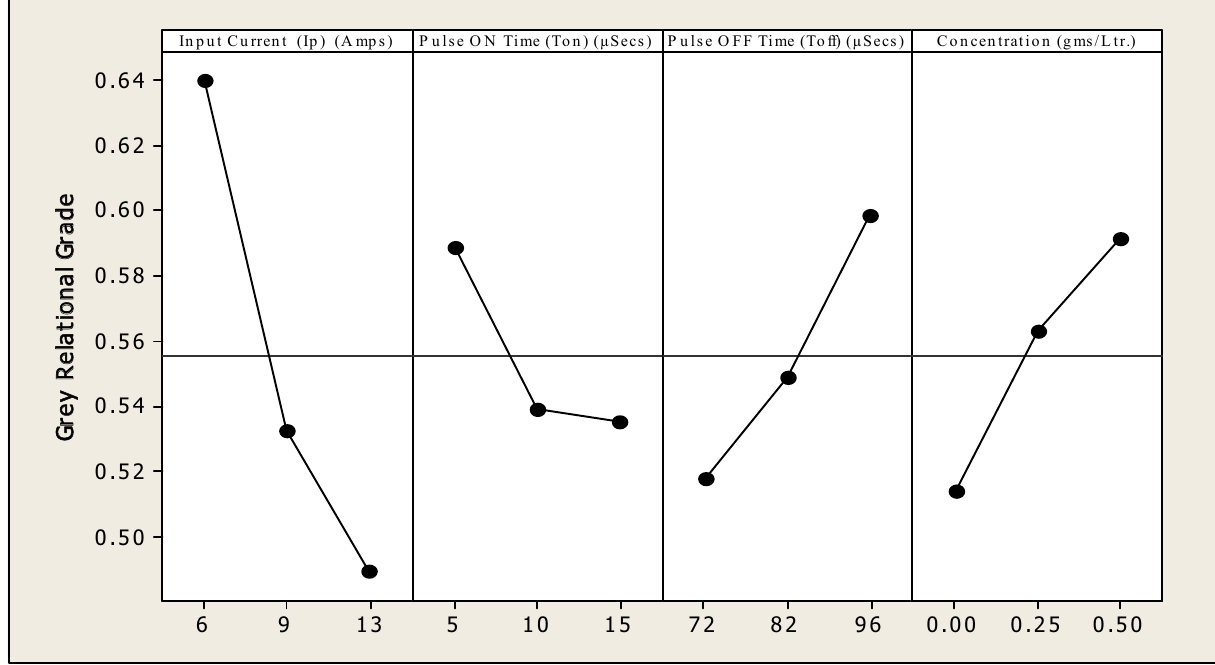
Fig. 3 Response plot for machining parameters